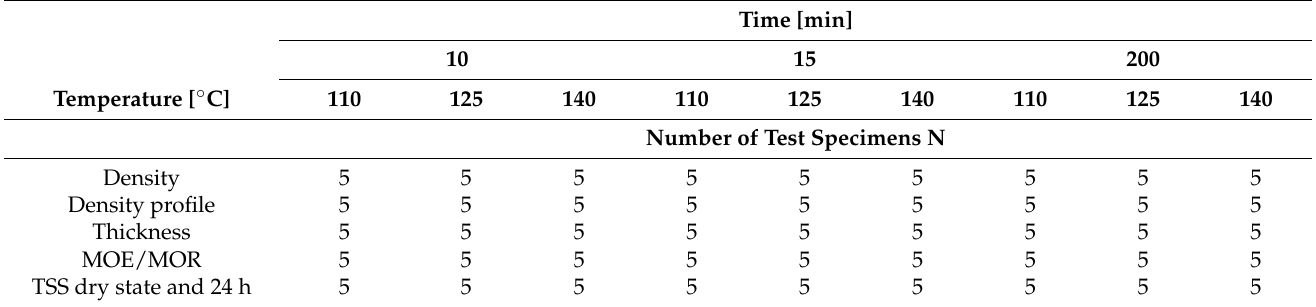
Table 1. Number of test specimen for the physical and mechanical properties testing of Quebracho tannin-furfural bonded five layered beech plywood. Time